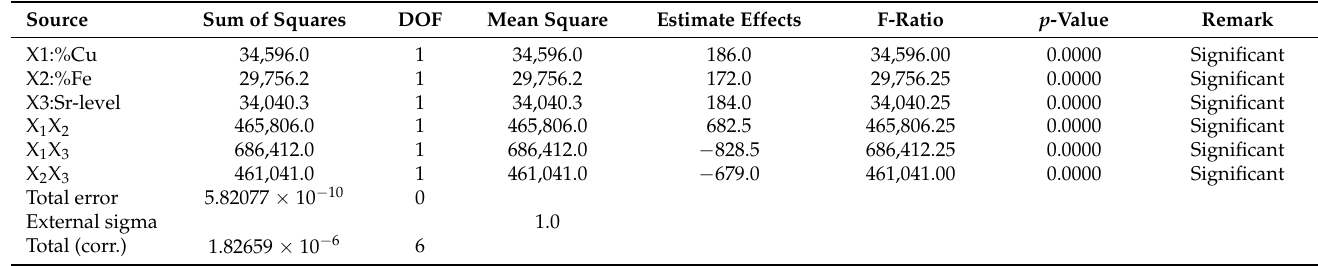
Table 10. Analysis of variance (ANOVA) for tool life data (number of